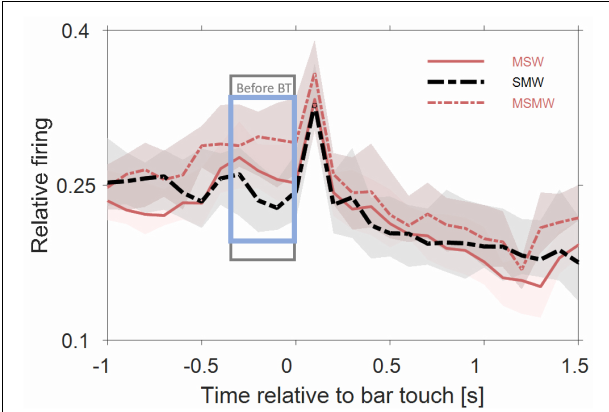
FIGURE 5 | Population firing rates of 180 multiunits in auditory cortex of two instrumentally-trained monkeys relative to bar touch. Conventions as in Figure 3 . Data from tone-alone and noise-tone trials were combined. For the two self-initiated conditions, we disregarded the phasic sound responses to the first sound after the bar touch. The rectangles denote time intervals in which there was a significant difference in firing rates between the SMW and MSW condition (gray) or between the SMW and MSMW condition